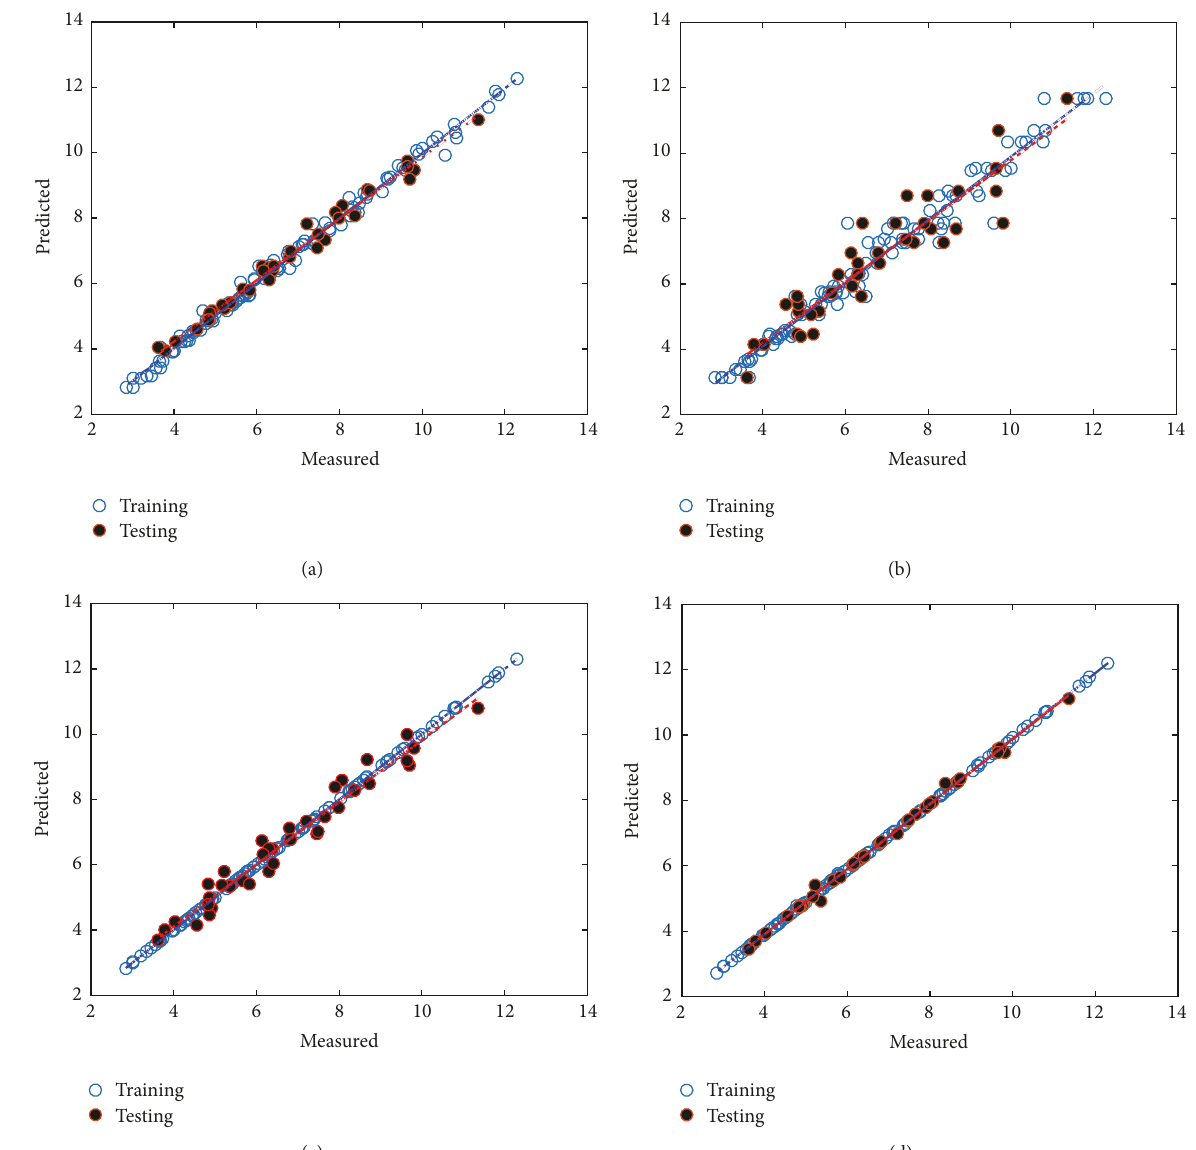
Figure 9: Measured and predicted settlement for the (a) MARS, (b) M5Tree, (c) GRNN, and (d) SVR models.